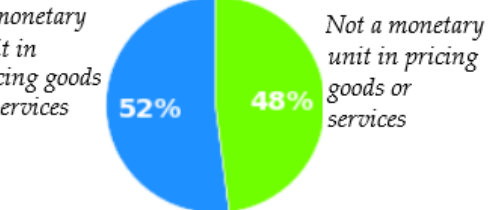
Figure 12. Answers for question of what functions of currency do you think that cryptocurrencies have?